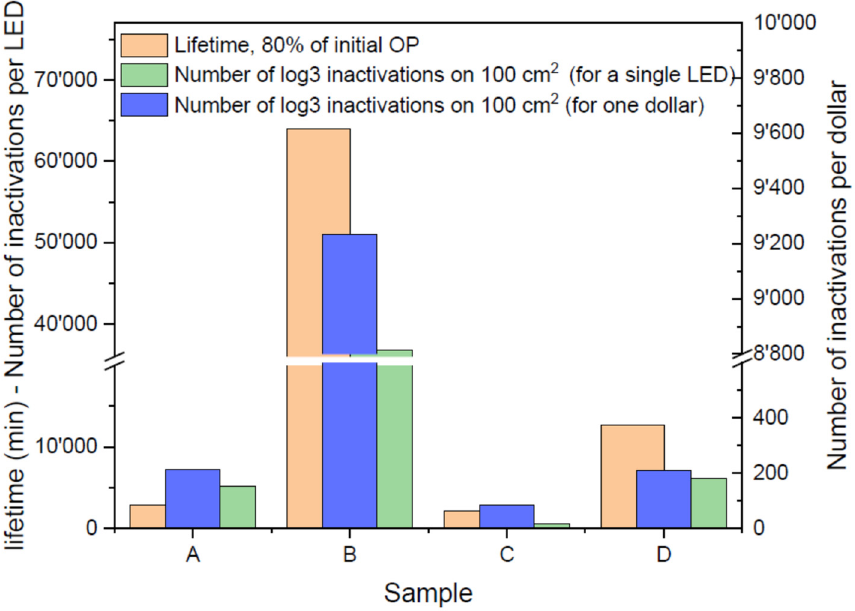
Figure 33. Summary of tested LED lifetime at 80% of initial optical power after stress at maximum current. Reproduced with permission. [89] Copyright 2022, MDPI.